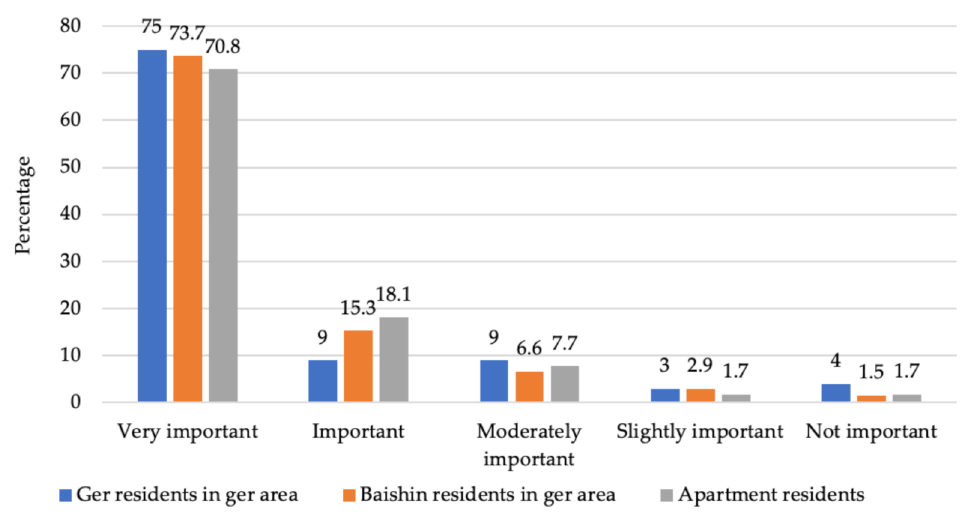
Figure 3. Respondents’ perception about the importance of community participation in urban park